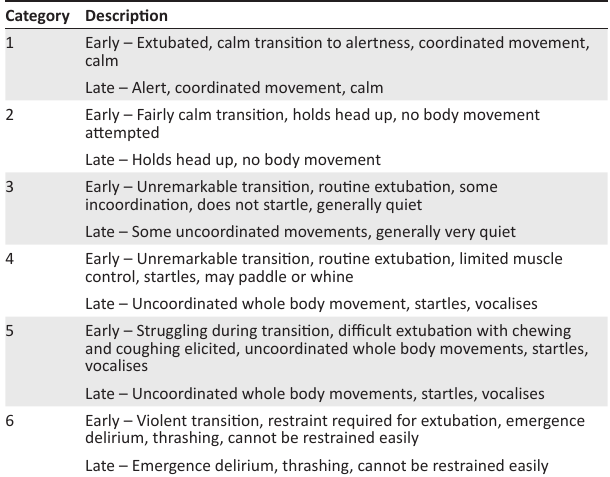
TABLE 3: Peri-trial observations on dogs presented for orchidectomy in which anaesthesia was induced with either diazepam-ketamine (Group D/K, n = 18) or propofol (Group P, n = 18) prior to maintenance with